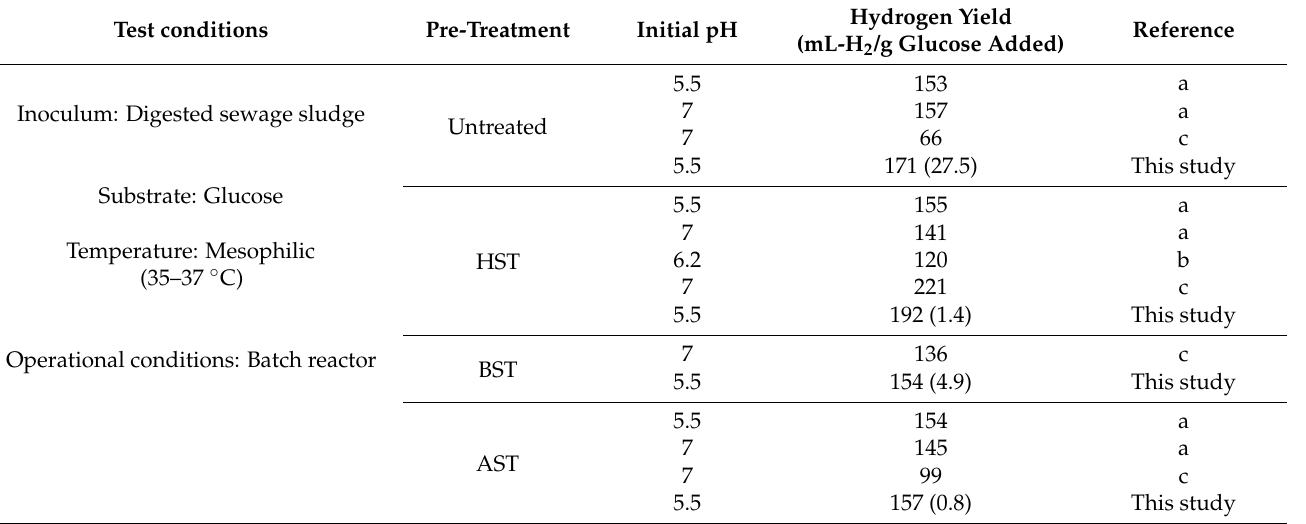
Table 3. Comparison of different inoculum pre-treatment methods in BHP